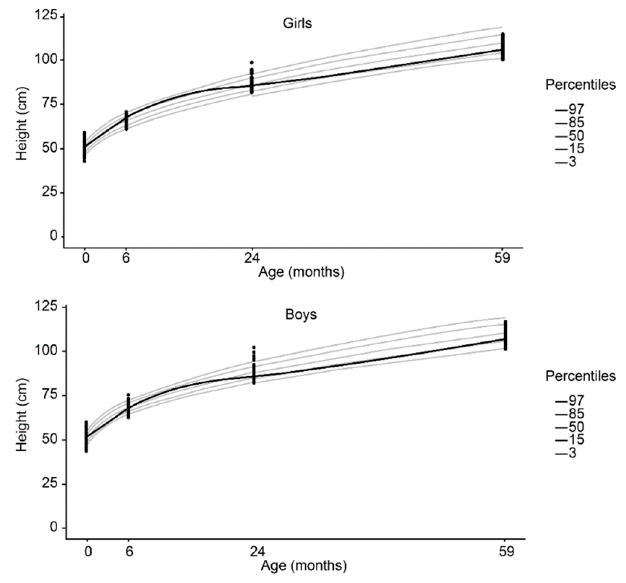
Figure 4. Height according to age adjusted by the cubic spline function for both female ( upper ) and male ( lower ) sex.